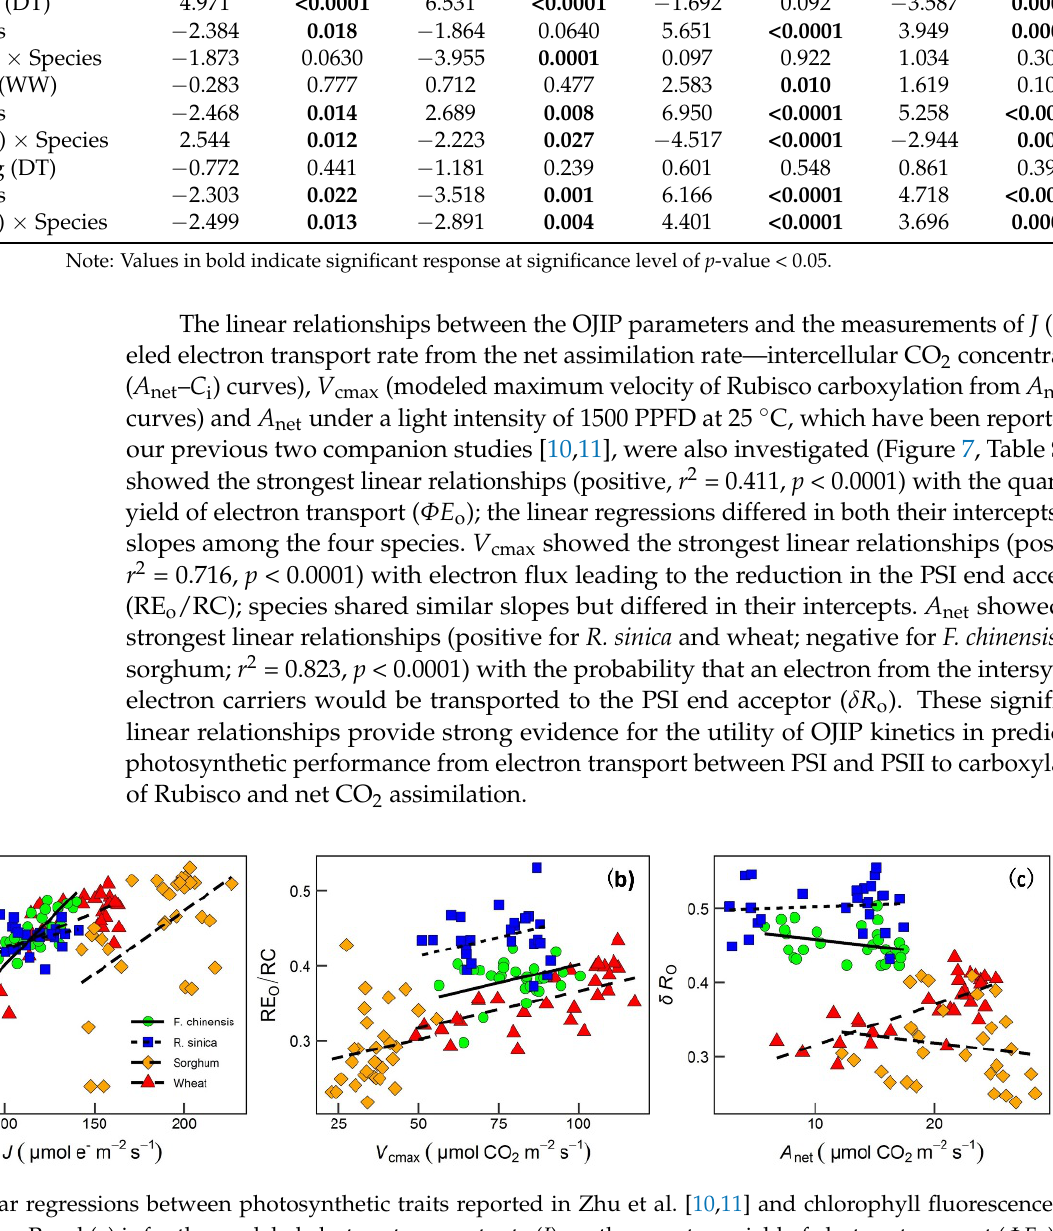
Table 3. Results of linear mixed-effects analysis of variance on the effects of heat stress combined with pre-existing drought. Φ P O Treatments